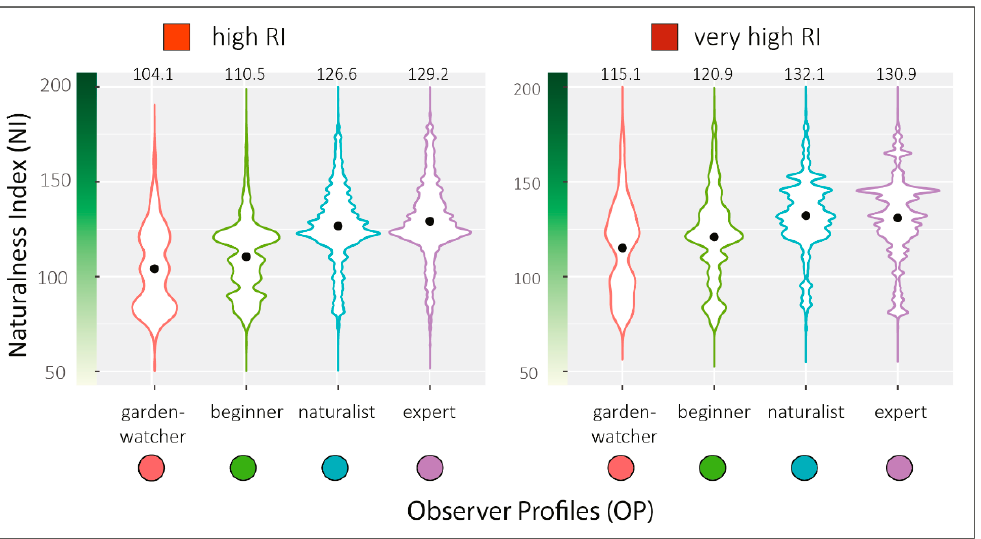
Figure 6. Violin plots of the mean NI of the four observer profiles (garden-watchers, beginners, naturalists, and experts), focusing only on high RI class ( left ) and very high RI class ( right ). Shapes of violin represent the kernel density of the NI data records.